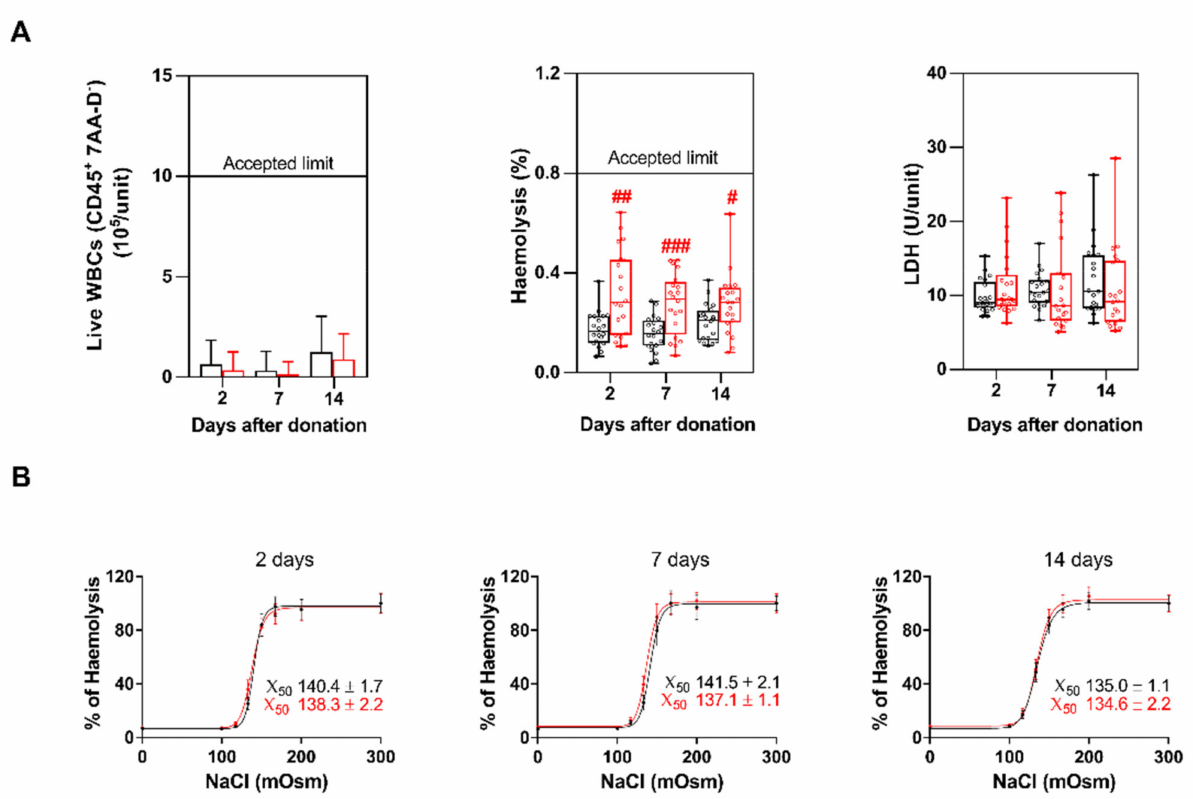
Figure 3. Residual live WBCs, hemolysis, LDH and erythrocytes fragility in the two methods at 2, 7, and 14 days after storage. ( A ) Mean live WBCs ± SD, single values of the percentage of hemolysis, and single values of LDH levels. N = 20 samples were collected for each condition; ( B ) Erythrocytes fragility at all the time points. Each value was collected in triplicate for n = 20 samples and expressed as mean ± SD. Points were fitted using a sigmoidal function to obtain the X 50 values reported in the figures. Method 1 is in black, method 2 in red. The boxplots were prepared as described in Figure 2. Red # indicate significant differences between the two methods at the various time points. # p < 0.05, ## p < 0.01, ### p < 0.001.